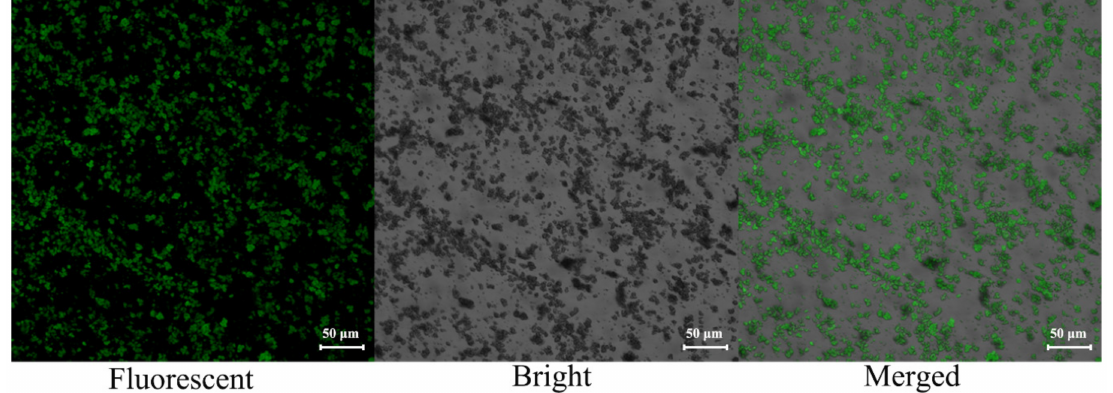
Figure 2. The laser confocal microscope (CLSM) images of NH 2